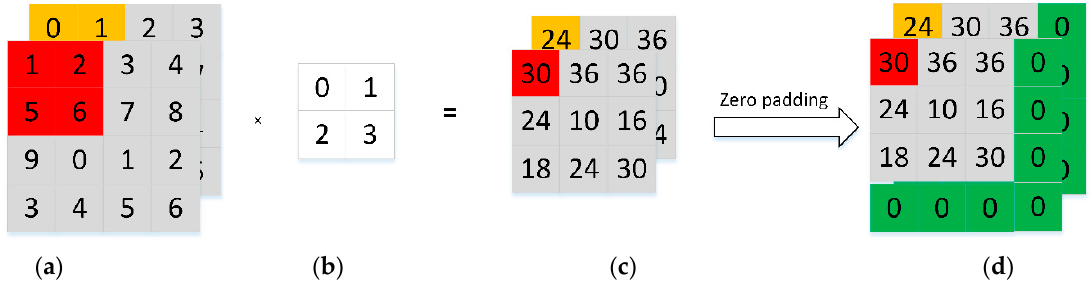
Figure 6. The process of convolution and zero padding. ( a ) presents the features before convolution. ( b ) presents the convolution kernel. ( c ) presents the features after convolution. ( d ) presents the feature after zero padding.